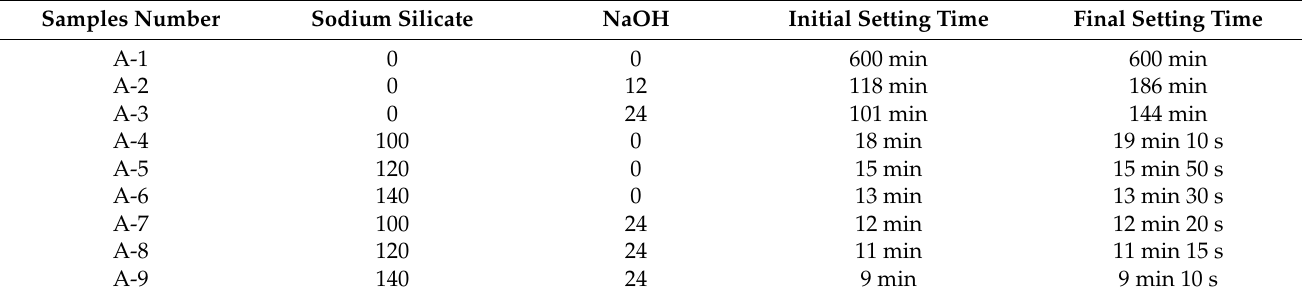
Figure 2. Effect of different initiator on initial/final setting time. Table 3. Setting time of BA alkali-activated paste samples